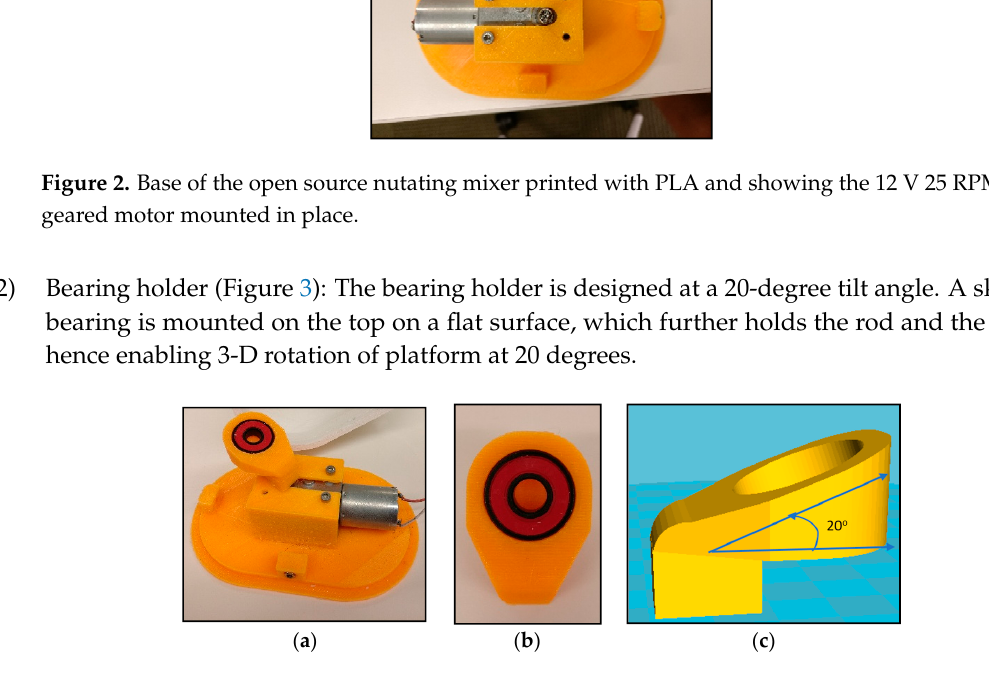
Figure 3. Bearing holder printed with polylactic acid (PLA). ( a ) in base; ( b ) detail; ( c ) FreeCAD side view showing 20° tilt angle.